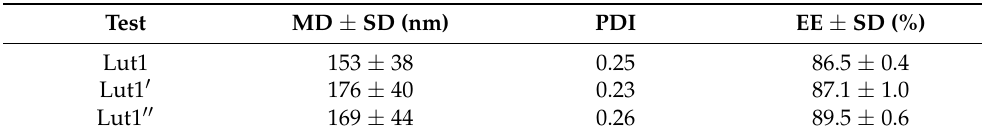
Table 2. Mean diameter (MD), PolyDispersity Index (PDI), and encapsulation efficiency (EE) obtained in reproducibility tests.